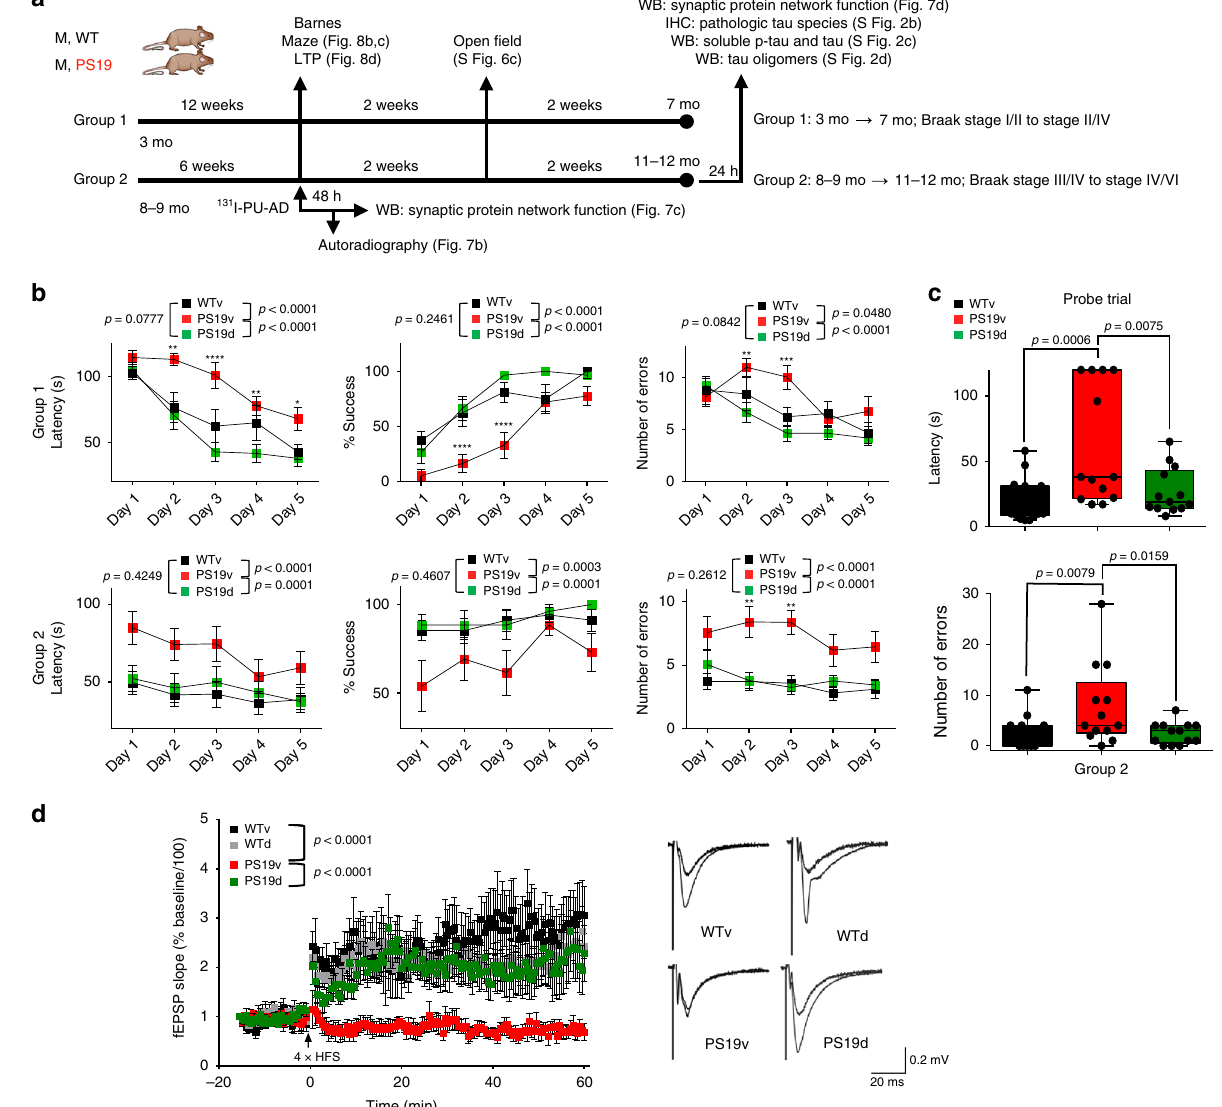
Fig. 8 Epichaperome inhibition restores synaptic plasticity and spatial learning and memory in PS19 mice. a Schematic of the treatment and testing paradigm. b , c Spatial learning and memory evaluated in the Barnes maze in PS19 treated with either PU-AD (PS19d) or vehicle (PS19v), and in vehicle treated WT mice (WTv) as in ( a ). Acquisition phase: two-way ANOVA, Bonferroni post hoc ( b ). Probe test (probe memory retention trial performed 24 h after the last acquisition session): one-way ANOVA, Dunnett ’ s post hoc ( c ). Group 1; n = 8 WTv, n = 9 PS19v, n = 15 PS19d; Group 2; n = 17 WTv, n = 13 PS19v and n = 13 PS19d. See also Supplementary Fig. 6B. d Long-term potentiation (LTP) induced in slices from WT and PS19 mice treated with vehicle or PU-AD as indicated in ( a ), Group 2. Representative traces are also shown. Graph, mean ± SEM, two-way ANOVA, n = 7 WTv, n = 6 WTd, n = 5 PS19v and n = 10 PS19d. **** P < 0.0001, *** P < 0.001, ** P < 0.01, * P < 0.05. Source data are provided as a Source Data fi WT mice (Fig. 8b, c). In Group 2, which displayed the highest epichaperome levels, long-term memory impairments were found in PS19 mice (number of errors, P = 0.0074, F (2, 40) = 5.56; latency, P = 0.0009, F (2, 40) = 8.432). This was also signi fi cantly improved upon PU-AD treatment, where we observed treated PS19 mice to behave statistically the same as age-paired WT mice.